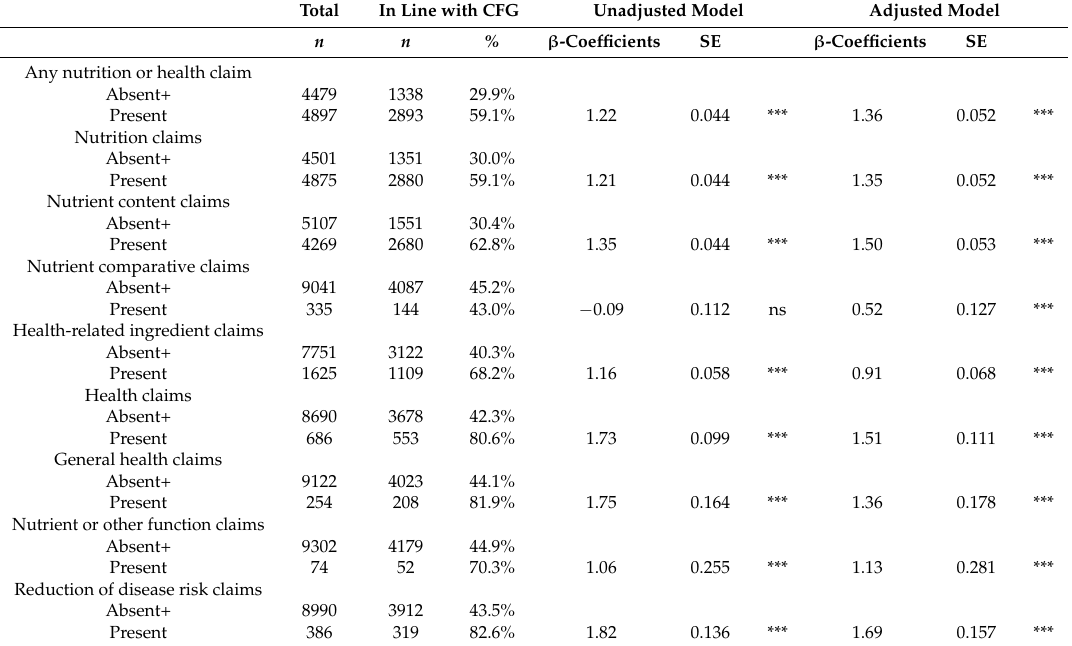
Table 3. Associations of foods carrying different types of claims to CFG recommendations ( n = 9376) 1,2 . Total In Line with CFG Unadjusted Model Adjusted Model n % β -Coefficients β